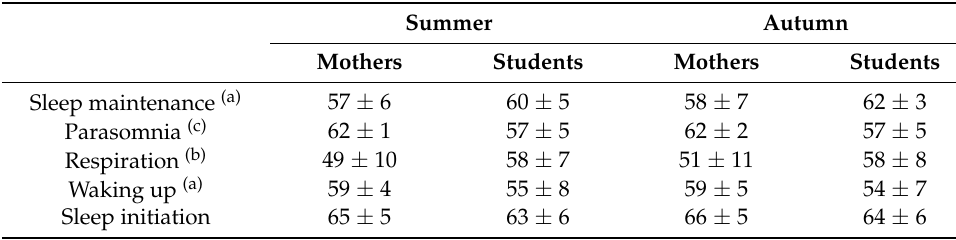
Table 4. The results of